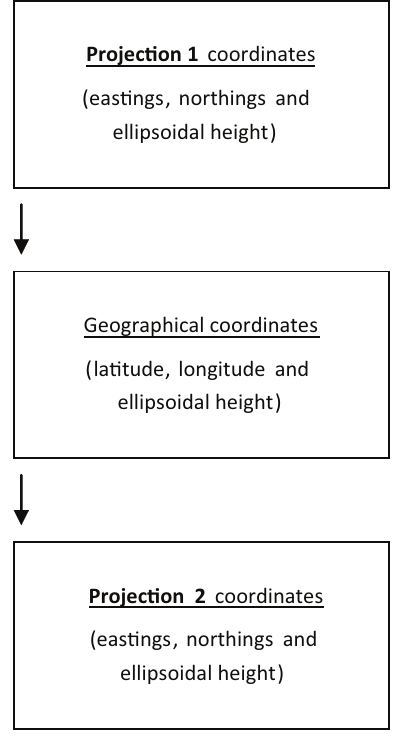
Fig. 1. The process to convert the result of GNSS